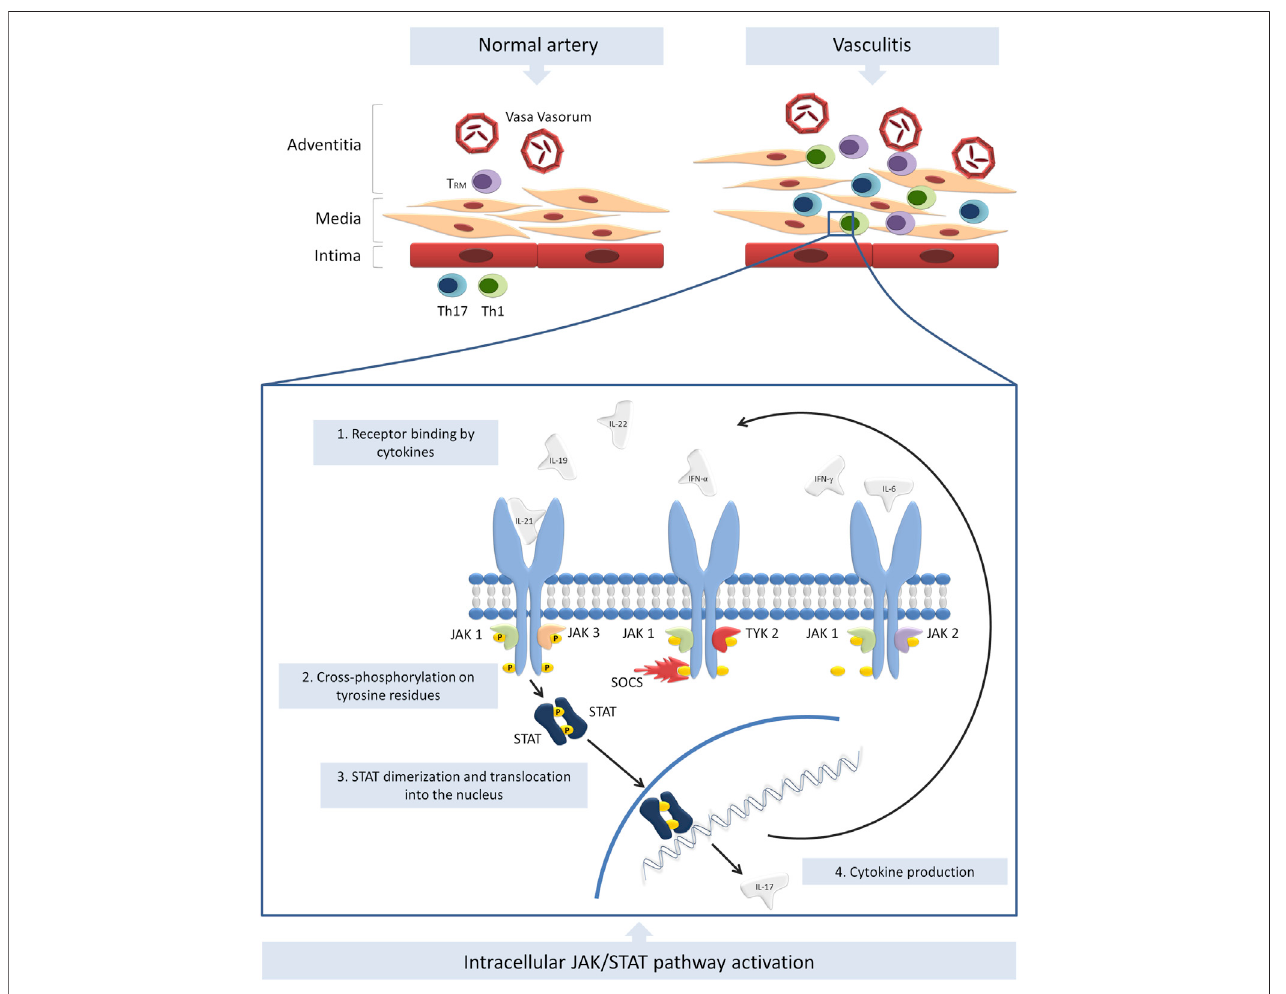
FIGURE 1 | Summary of the current evidence on the role of JAK/STAT pathway in the pathogenesis of vasculitis. T RM , Th1 and Th17 cells in fi ltrate the vessel wall and induce in fl ammation. Numerous cytokines are secreted by T cells and innate immunity cells and activate JAK/STAT pathway. Other cytokines, such as IL-17 are thereforeproduced ansecreted,furtheramplifyingthein fl ammatory response. Themodulation ofSOCStranscriptionmaybeanother altered mechanisminvolvedinthe pathogenesis of vasculitides.